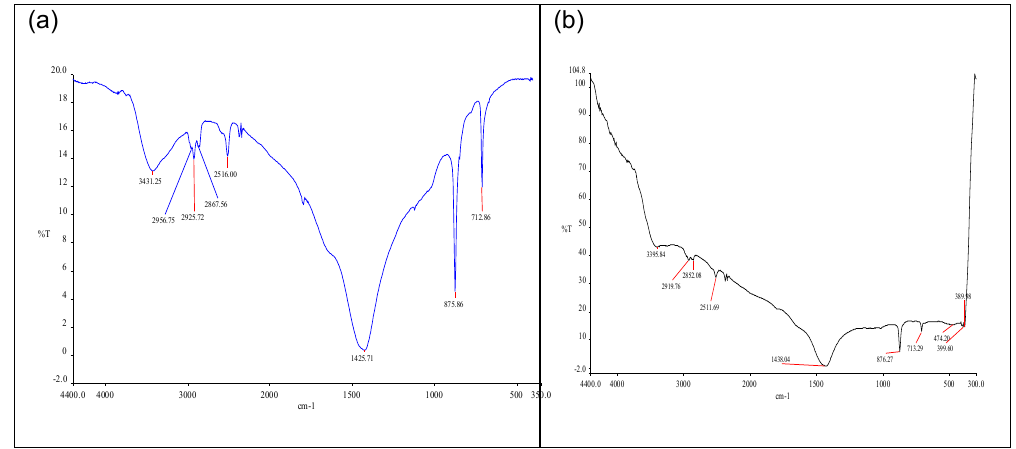
Figure 2. IR Spectrum of eggshell powder (a) before fluoride loaded and (b) after fluoride loaded.